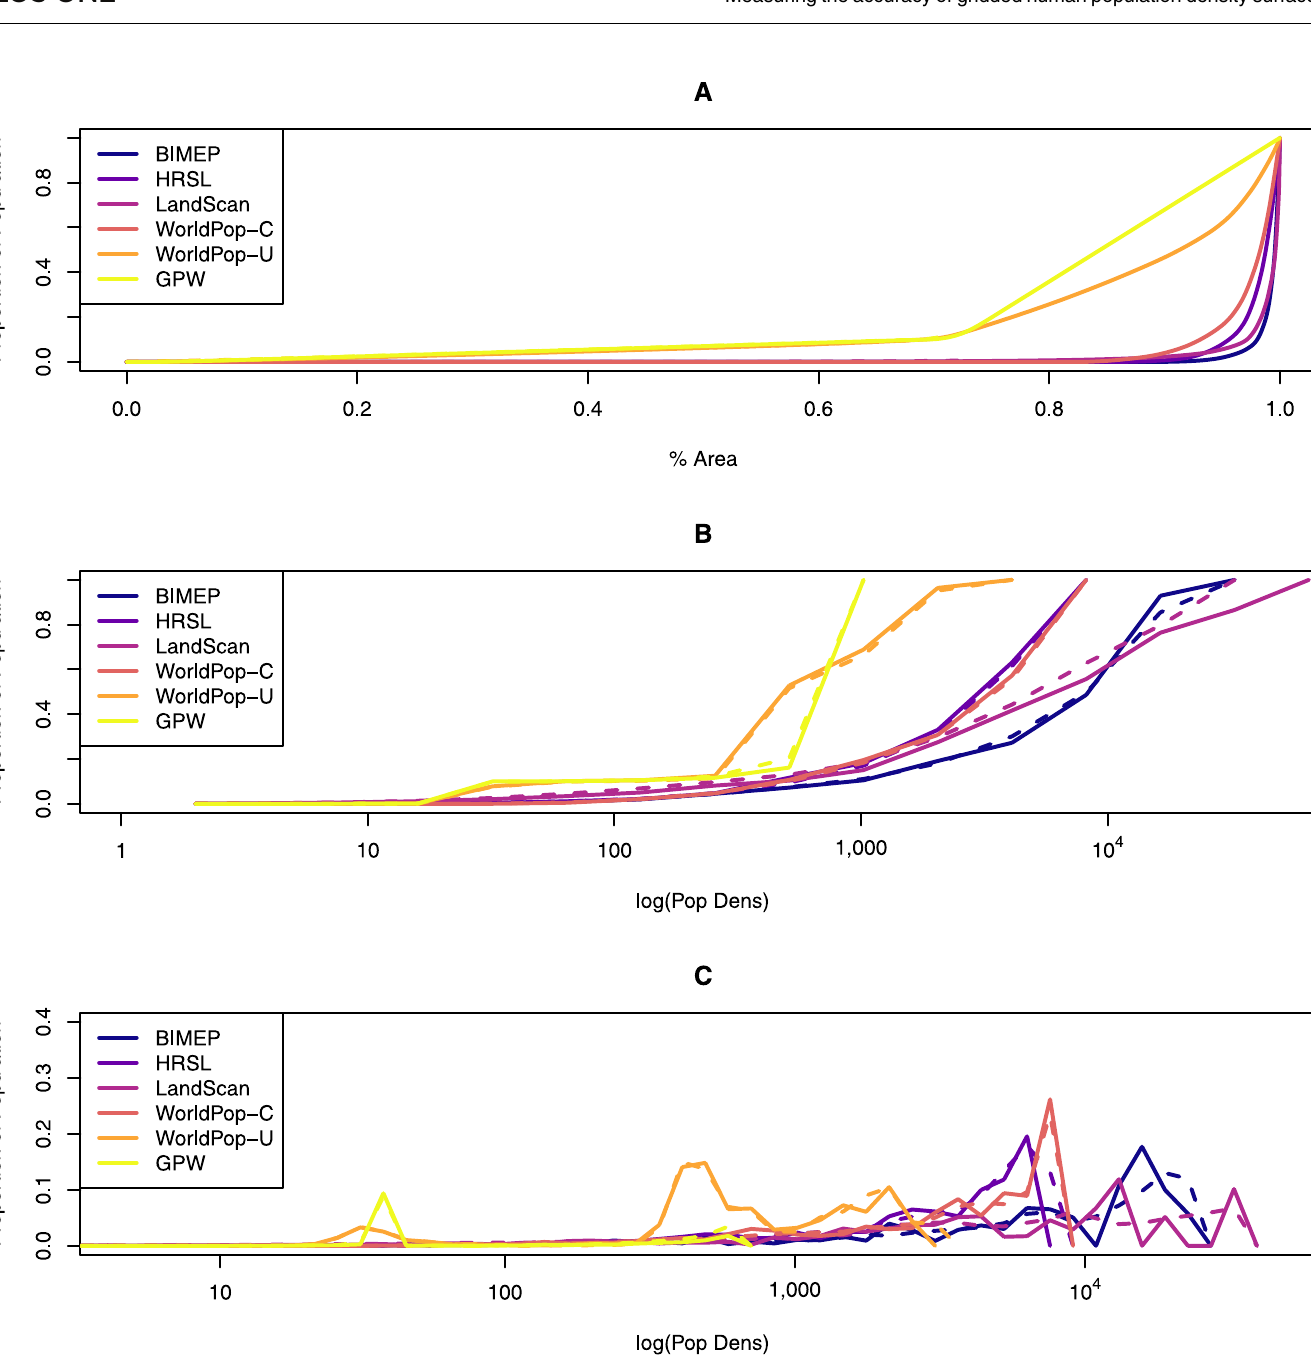
PLOS ONE | https://doi.org/10.1371/journal.pone.0248646 September 1,